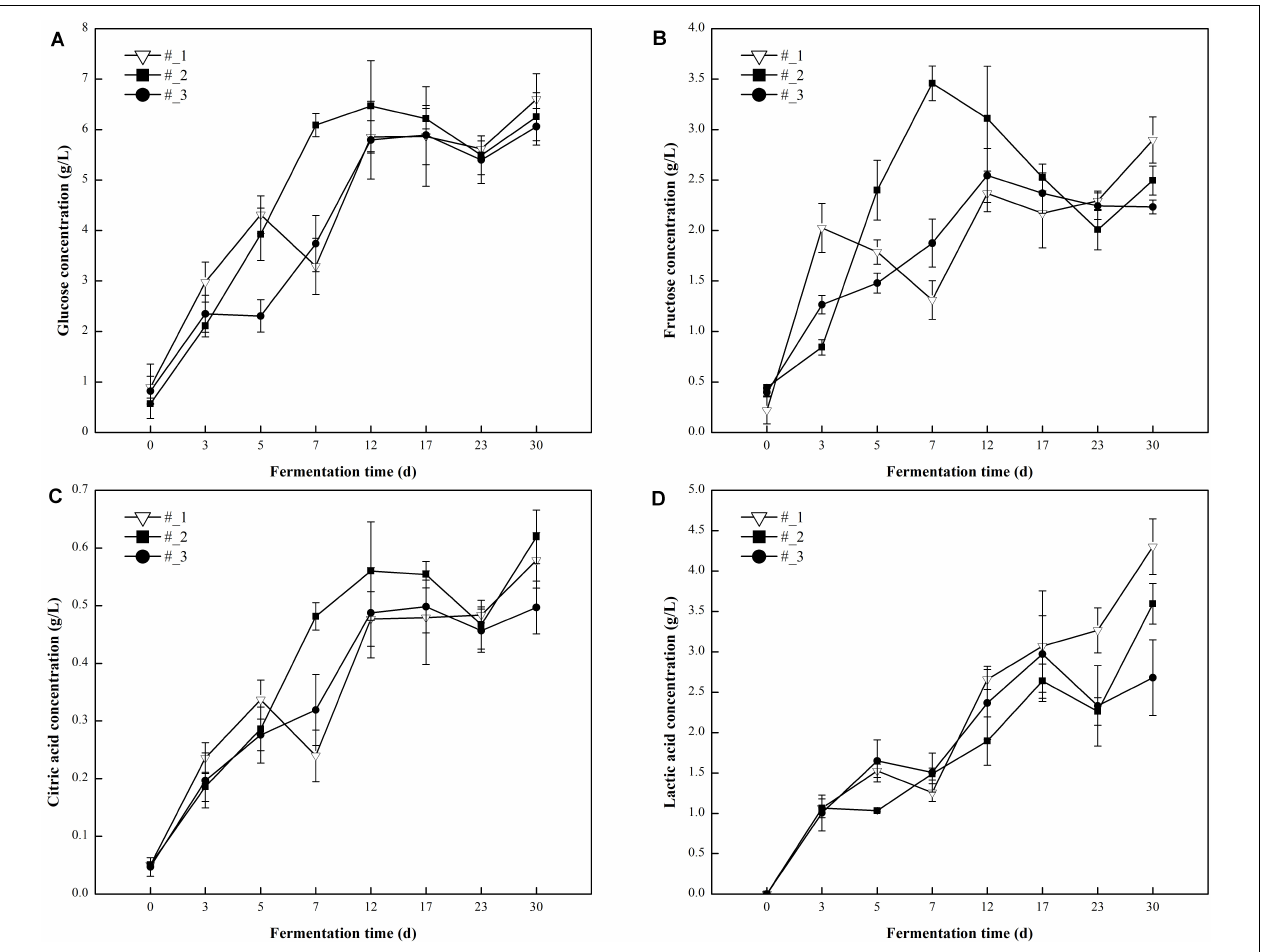
FIGURE 4 | Changes in the concentration of non-volatile metabolites [ (A) -Glucose, (B) -Fructose, (C) -Critic acid, (D) -Lactic acid] during traditional northeast sauerkraut fermentation from different households. #1, #2, and #3 represented three different households.